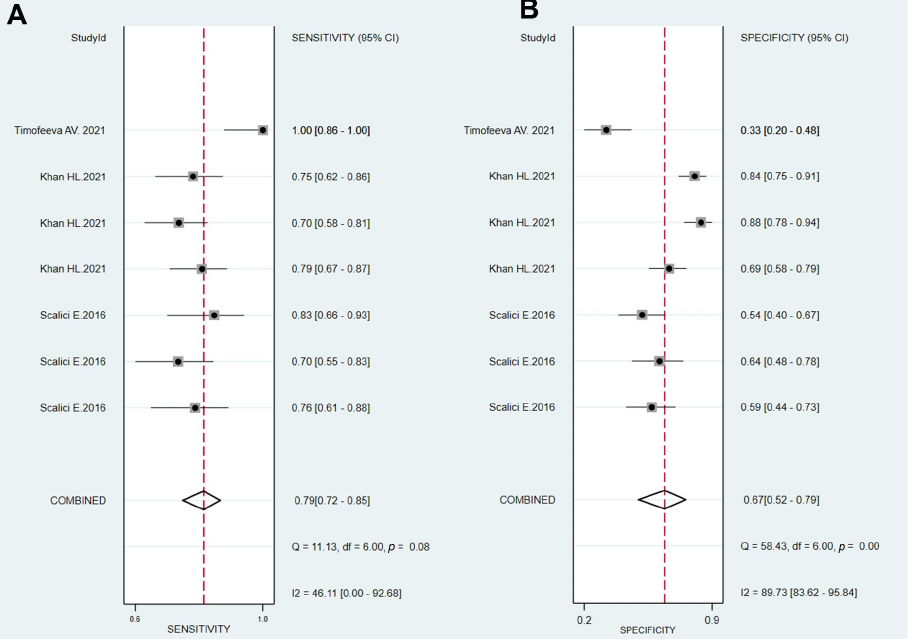
Figure 2. Pooled predictive performance of extracellular sncRNAs for embryo implantation poten- tial. Data from three published articles [45,55,59] were analyzed. ( A ) Forest plots of the pooled sen- sitivity. ( B ) Forest plots of the pooled speci fi city. ( C ) SROC curve. ( D ) Deeks’ funnel plot. ( E ) Fagan’s plot.